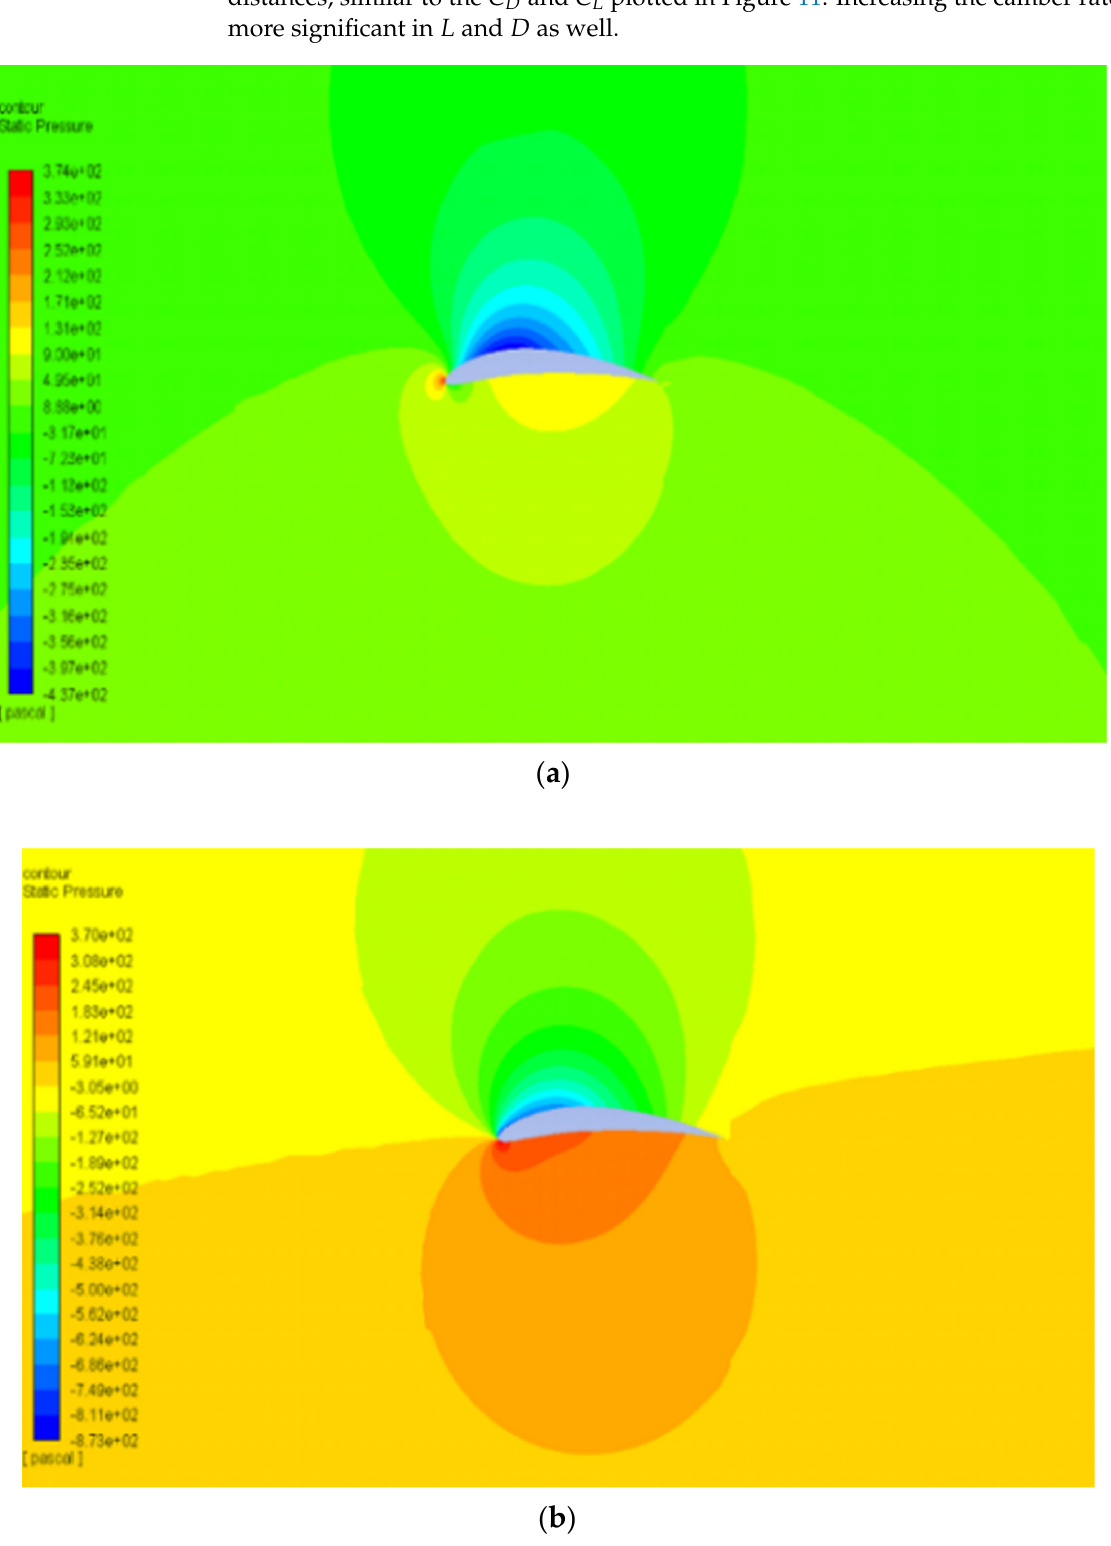
Figure 12. Pressure contour of NACA8410 with AoA ( a ) 1° and ( b ) 8°.